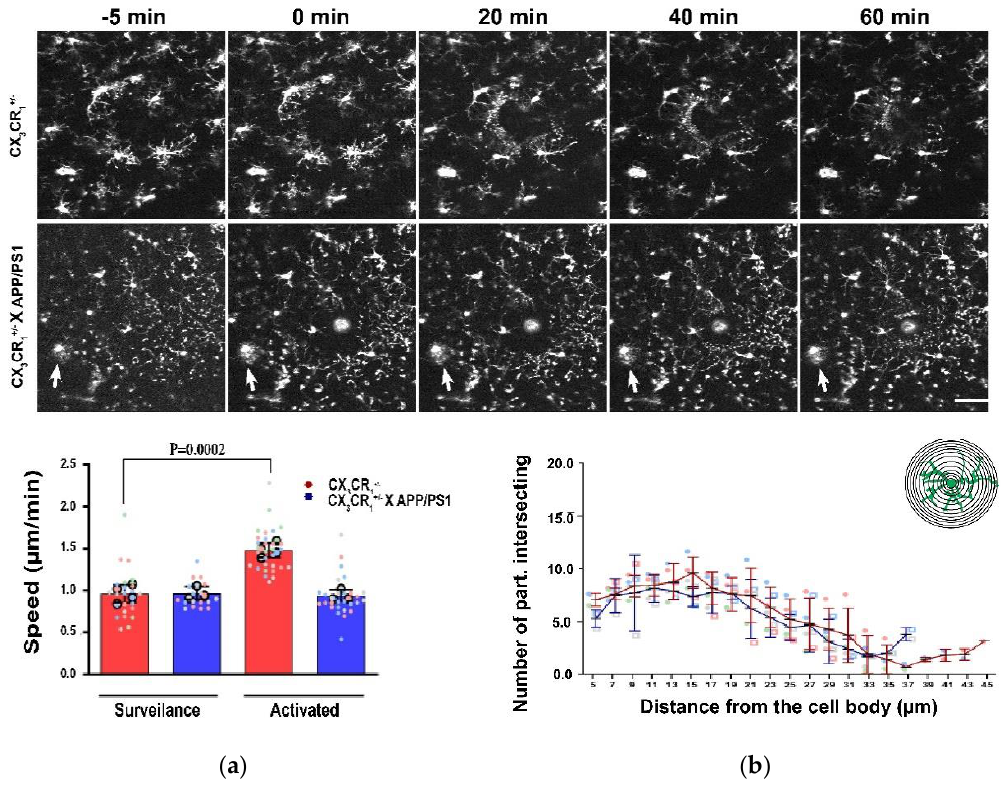
Figure 1. Time-lapse recordings of the same cortical region before and after a micro lesion was done with a laser shows how microglia will rapidly isolate the lesion site from the healthy brain, as to stop the spread of the damage. ( a ) In the presence of amyloid microglia are slower to react to the lesion although the surveillance speed in the intact parenchyma is comparable between tissue with and without amyloid; ( b ) Analyzing microglia morphology using a Scholl approach has revealed no difference in the number of intersections from the cell body but revealed that in the presence of amyloid, microglia appear to have a shorter process arborization. Data collected from 4 animals only expressing CX 3 CR 1 (29 analyzes cells) and from 3 animals expressing both CX 3 CR 1 and APP/PS1 mutations (26 analyzed cells). Mean and standard deviation is shown. APP: amyloid precursor proteins; PS1: presenilin